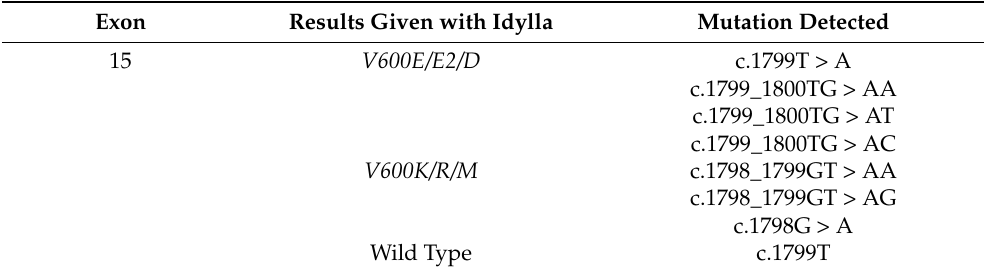
Table 1. Overview of mutations detected with the Idylla BRAF Assay (Idylla TM platform—Biocartis, Mechelen,